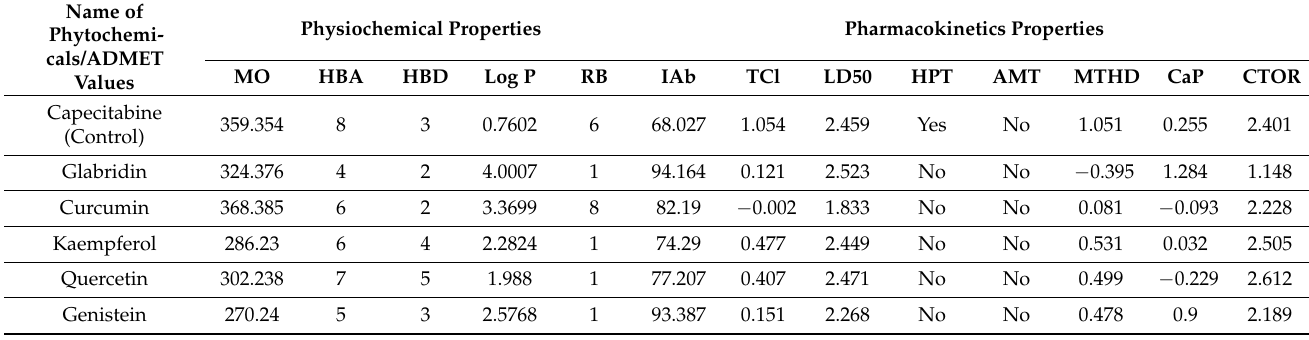
Table 2. The complete pharmacophore and pharmacokinetic profiling of the selected ligands. Name of Phytochemi-